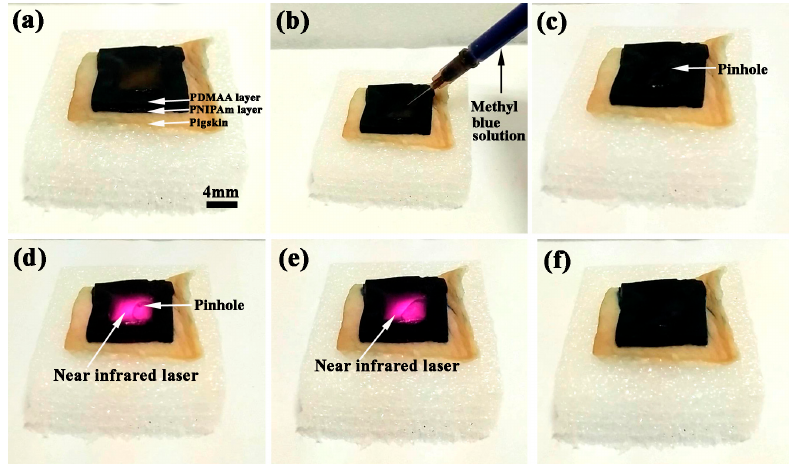
Figure 10. The adherency and self-healing process of bilayer hydrogel ( a ) covered on the pigskin; ( b ) and ( c ) injection of methyl blue solution; ( d , e ) self-healing process of pinhole irradiated by near-infrared irradiation for 115 s; and ( f ) morphology of bilayer hydrogel after self-healing.